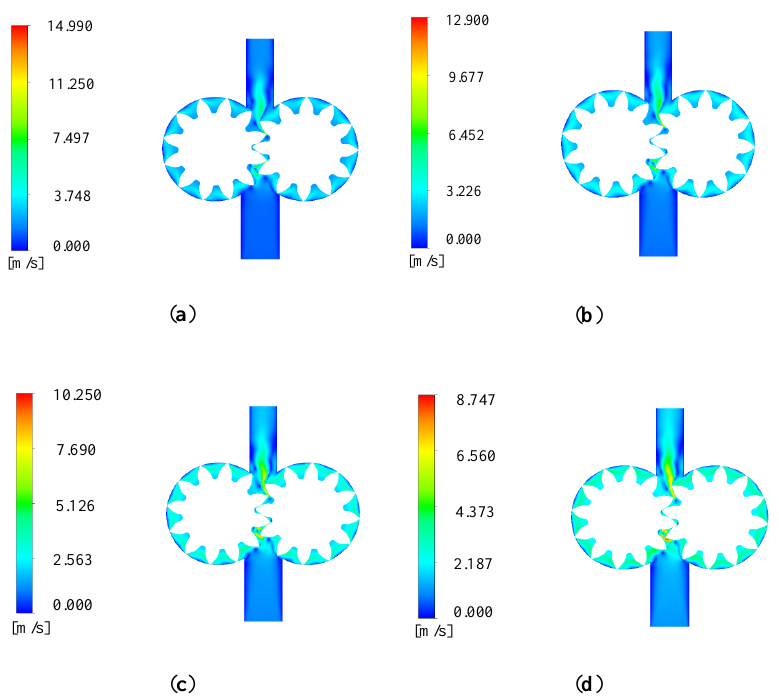
Figure 5. Velocity nephogram of 2D simulation model: ( a ) velocity nephogram at 0.01 s; ( b ) velocity nephogram at 0.02 s; ( c ) velocity nephogram at 0.03 s; ( d ) velocity nephogram at 0.04 s.